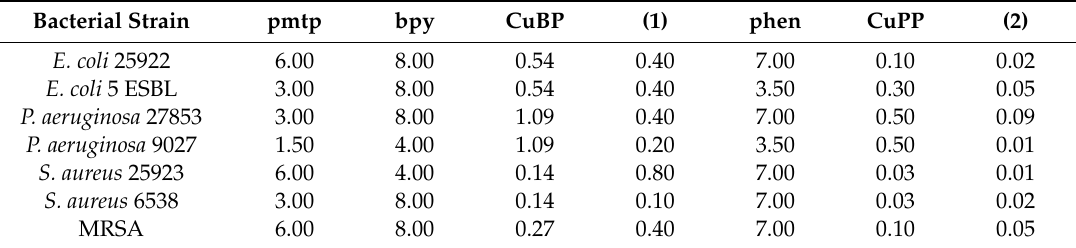
Table 4. The compounds influence on biofilm formation (MBEC value, mM). Bacterial Strain pmtp